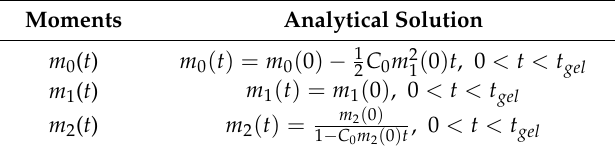
Table 1. Analytical solution for the first three moments for the aggregation process with product kernel.